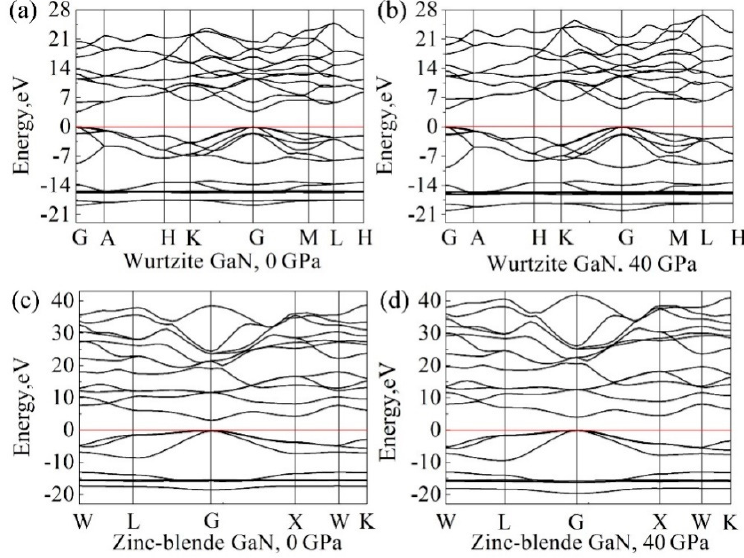
Figure 9. Band structures: ( a ) wurtzite GaN, 0 GPa; ( b ) wurtzite GaN, 40 GPa; ( c ) zinc-blende GaN, 0 GPa; ( d ) zinc-blende GaN, 40 GPa.